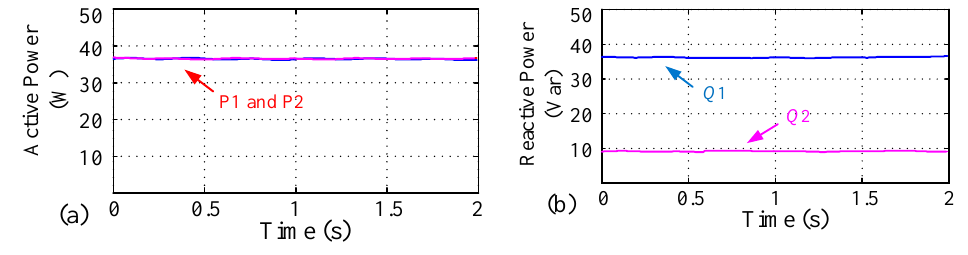
Figure 18. Steady-state power of Case I: ( a ) active power; and ( b ) reactive power.